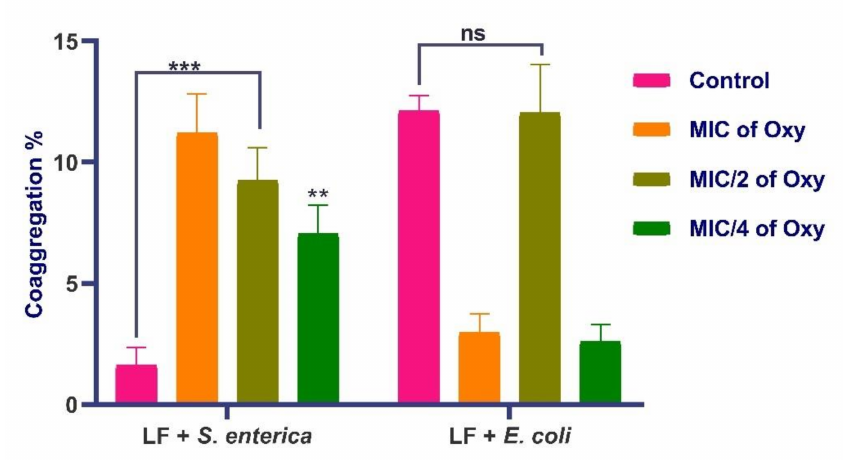
Figure 15. Coaggregation potential of L. fermentum ASBT-2 (LF) against S. enterica and E. coli MDR with different concentrations of oxyresveratrol. *** Significantly different ( p ≤ 0.001); ** significantly different ( p ≤ 0.01); ns: non-significant.